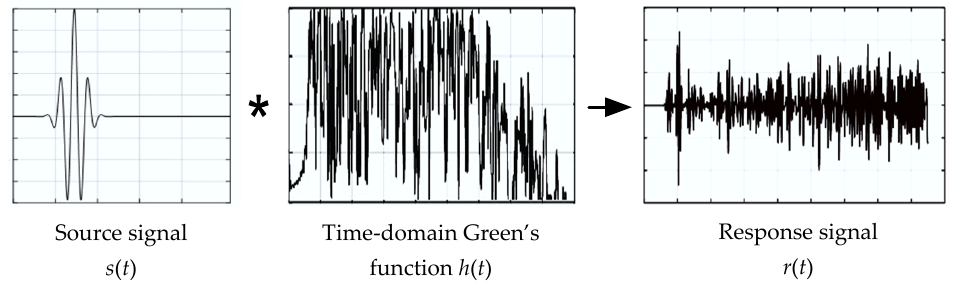
Figure 1. Received signal by the sensor due to a PD source signal considering the transformer as a linear, time-invariant system.